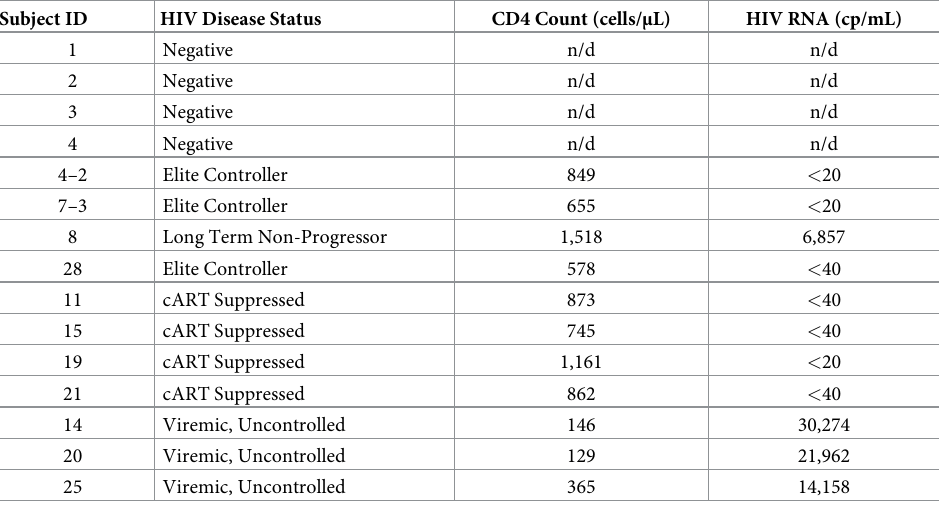
Table 1. Clinical description of study participants.